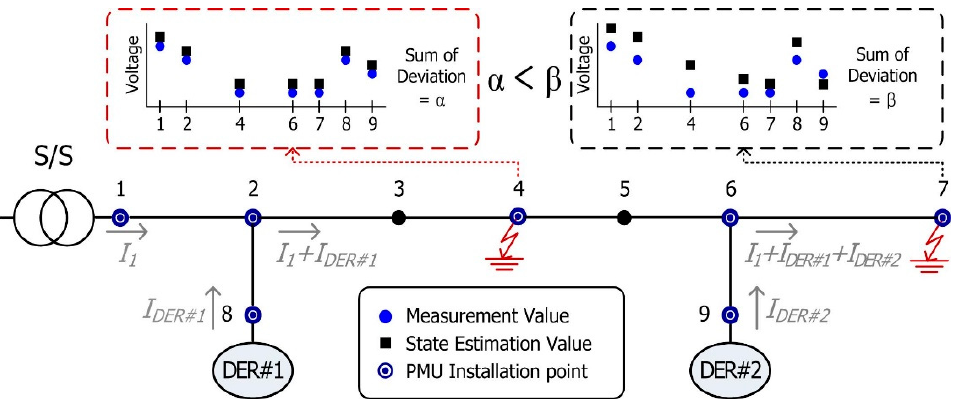
Figure 1. Outline of the phasor measurement unit (PMU)-based fault location method [11].